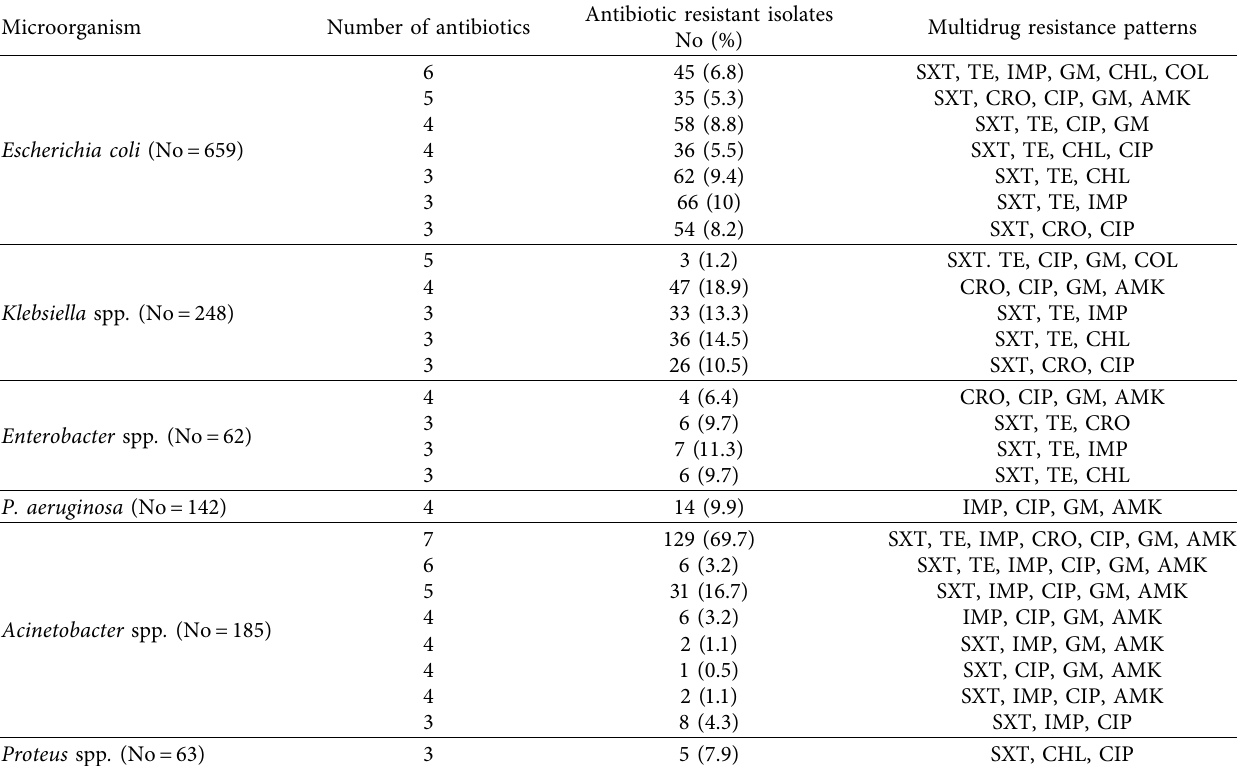
Table 7: Multidrug resistance patterns of Gram-negative bacteria isolated from patients with infections. Microorganism Number of antibiotics